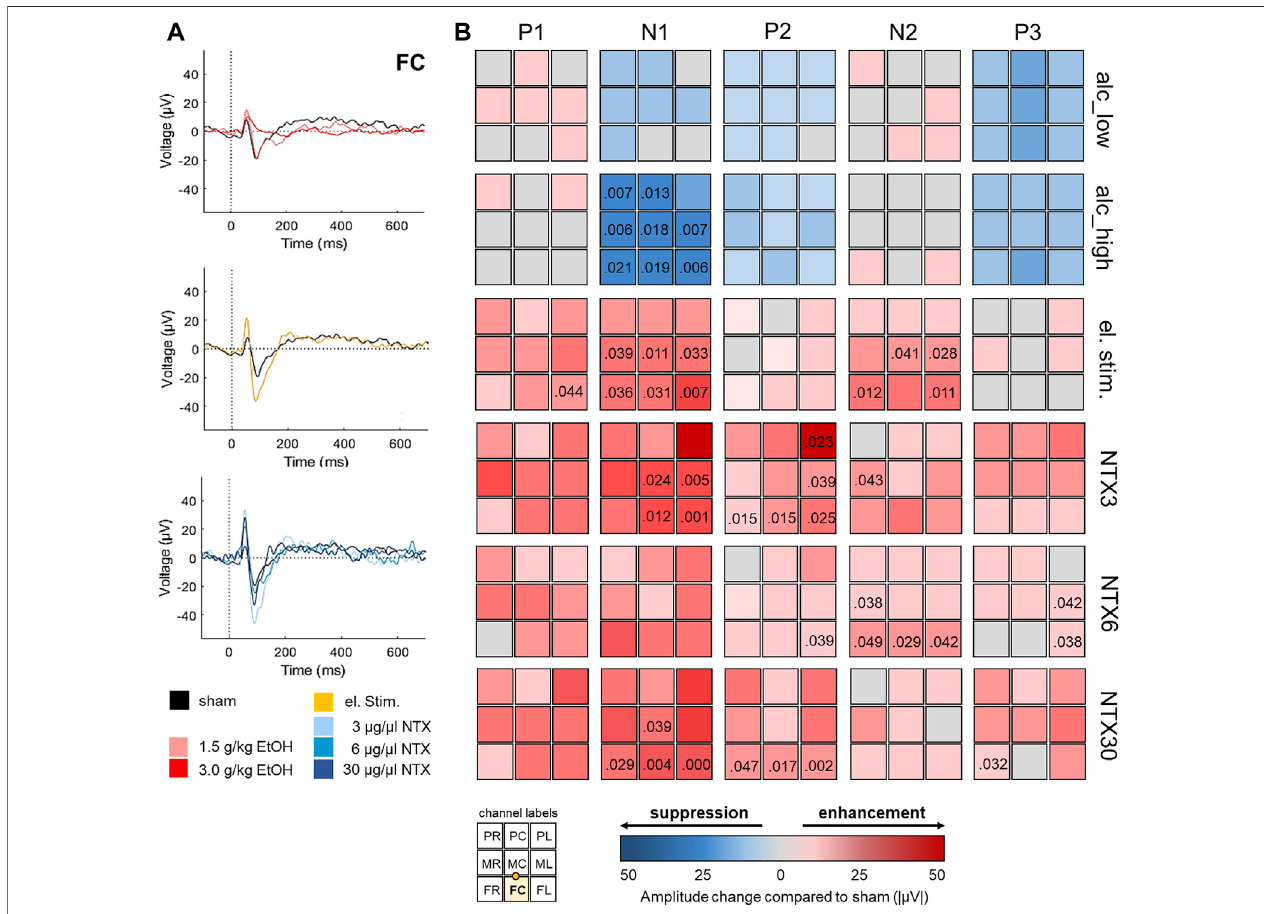
FIGURE 4 | Impact of alcohol and implant-driven electrical and pharmacological brain stimulation on prefrontal neural activity. (A) Representative grand average deviant-minus-standard ERP difference curves at channel FC following administration of alcohol at 1.5 g/kg (n (cid:1) 6, rose) and 3 g/kg (n (cid:1) 9, red), electrical brain stimulation(n (cid:1) 8, yellow), cortical delivery ofnaltrexone (NTX) at 3 μ g/ μ l(n (cid:1) 5,lightblue), 6 μ g/ μ l(n (cid:1) 4, mid-blue), and 30 μ g/ μ l(n (cid:1) 5, dark blue) and untreated animals (sham, n (cid:1) 10, black). (B) ERP amplitude differences between interventionsand untreated animalsat all channels. Implant channels are displayed in 3 × 3 matrices foreachtreatment(rows)andERPcomponent(columns)withsuppressingorenhancingtreatmenteffectsonERPamplitudesillustratedinblueishorreddishcolors.The bottom left inset illustrates channel locations with the highlighted FC stimulation electrode and the micro fl uidic channel between electrodes FC and MC. Numbers indicate signi fi cant p -values (uncorrected).